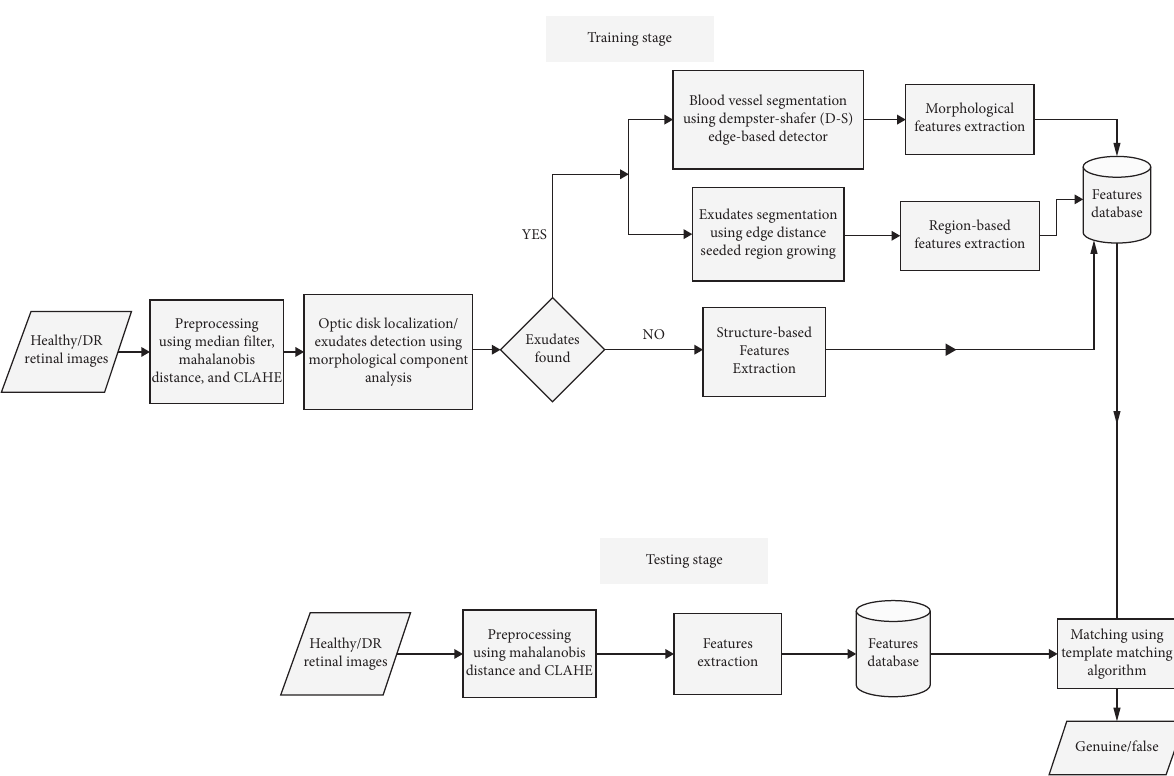
Figure 1: Block diagram of the proposed